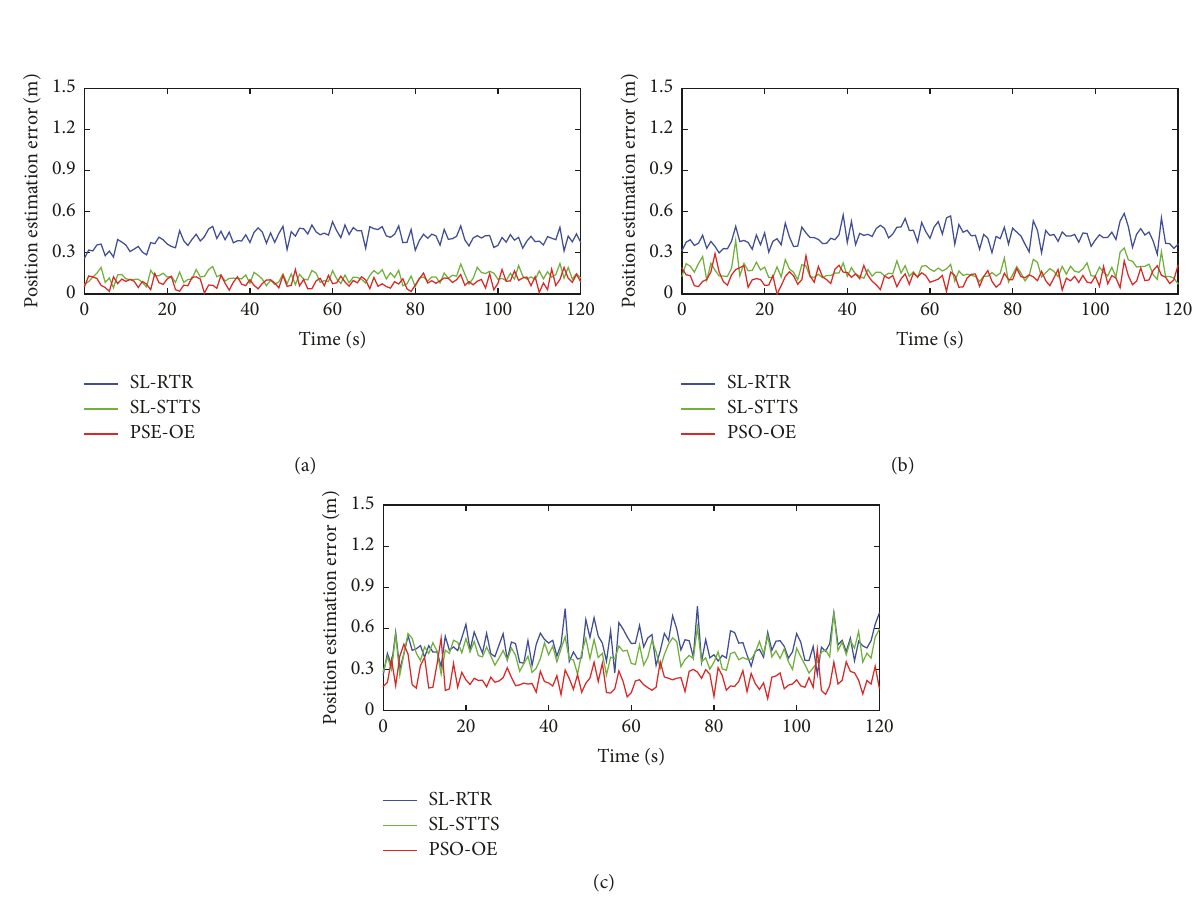
Figure 6: The localization error in the second experiment: (a) set 𝜎 2 𝑖 = 10 −2 ; (b) set 𝜎 2 𝑡 = 10 −8 , 𝜎 2 𝑎 = 0 ; (c) set 𝜎 2 𝑡 = 10 −7 , 𝜎 2 𝑎 = 10 −4